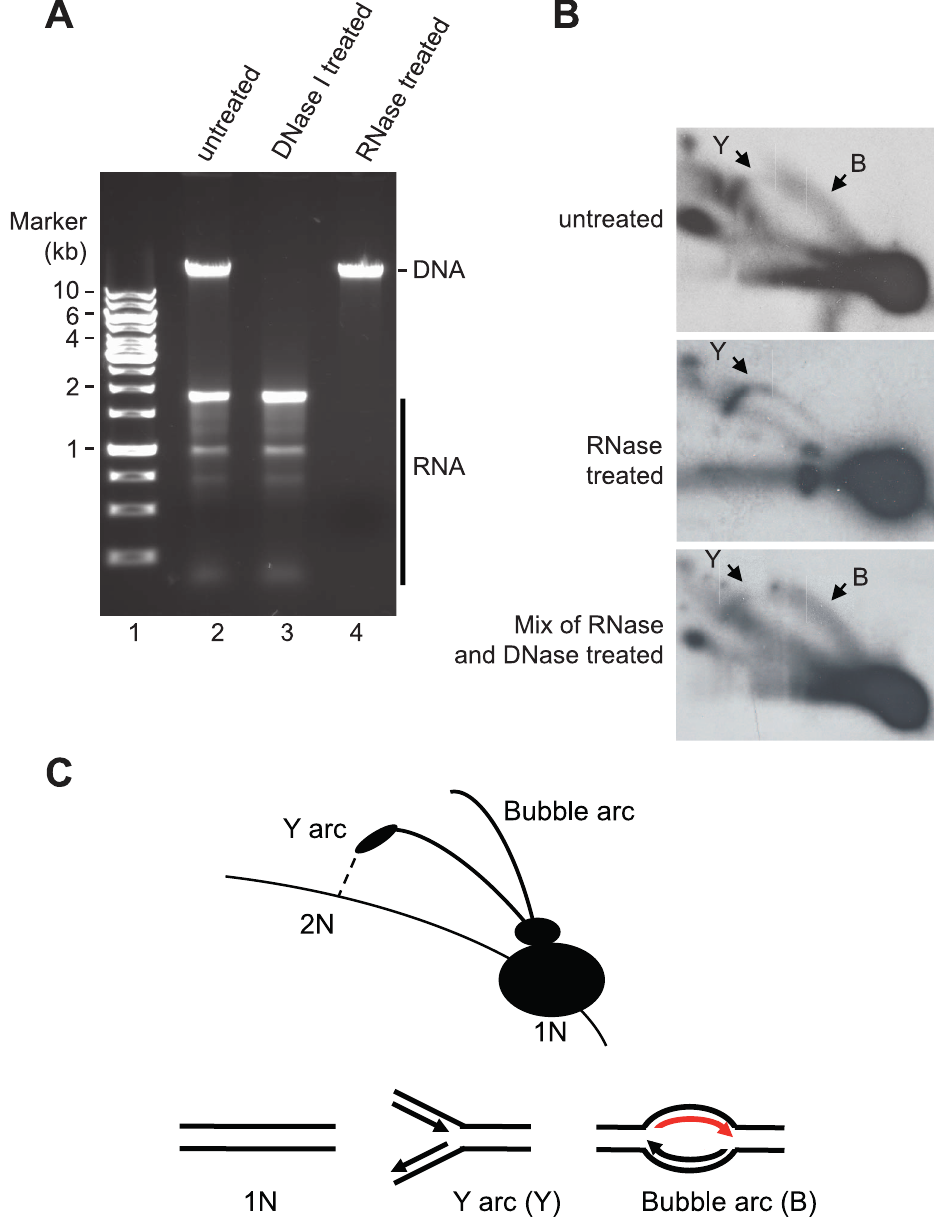
Figure 5. Neutral 2D-AGE analysis of mtDNA replication products. ( A ) Extracted DNA analyzed on 1% Agarose. ( B ) Purified DNA cut with HincII was analysed using 2D-AGE. A fragment (mtDNA 13636-1006 bp) spanning the OriH region was visualized with probe located in CYTB (14641- 15590 bp). Upper panel; untreated DNA (containing both RNA and DNA), Middle panel; RNase A and RNase H treated DNA (containing only DNA); Lower panel, DNA treated with RNaseA and RNaseH remixed with the RNA still present after DNase I treatment. ( C ) Schematic illustration of how Y and bubble arcs are expected to run in 2D-AGE. The bubble arc observed here is dependent on RNA (indicated in red).